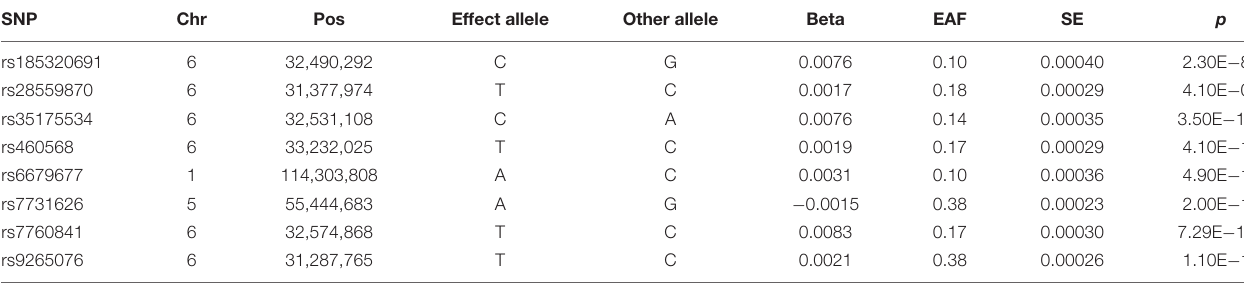
TABLE 1 | Characteristics of eight genetic variants as instrumental variables (IVs).